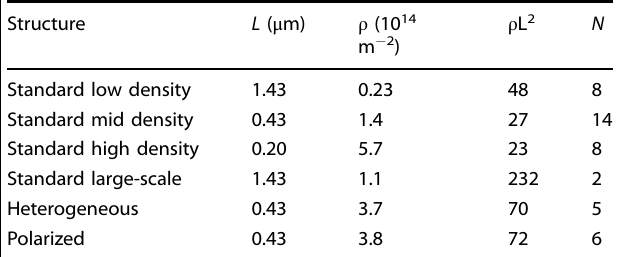
Table 1. Properties of the various dislocation microstructures generated for this study.